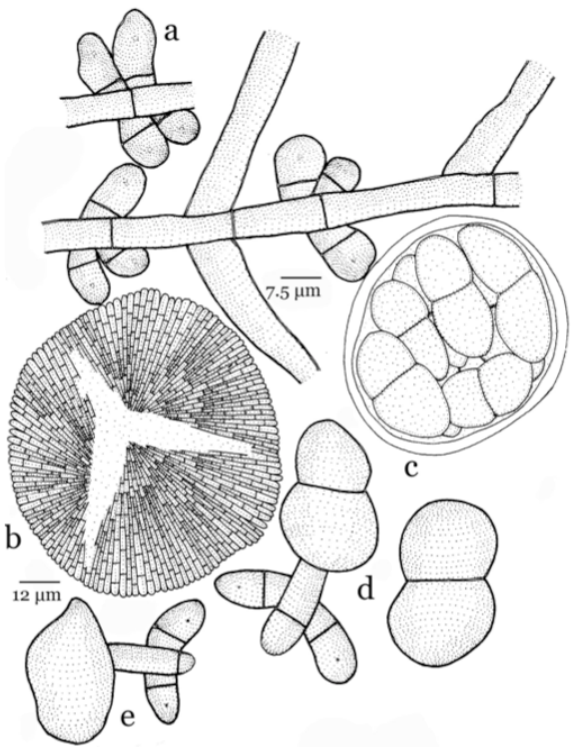
Figure 174. Ishwaramyces flacourtiae a - Whorled appressoria; b - Thyriothecium; c - Ascus; d - Ascospores; e -